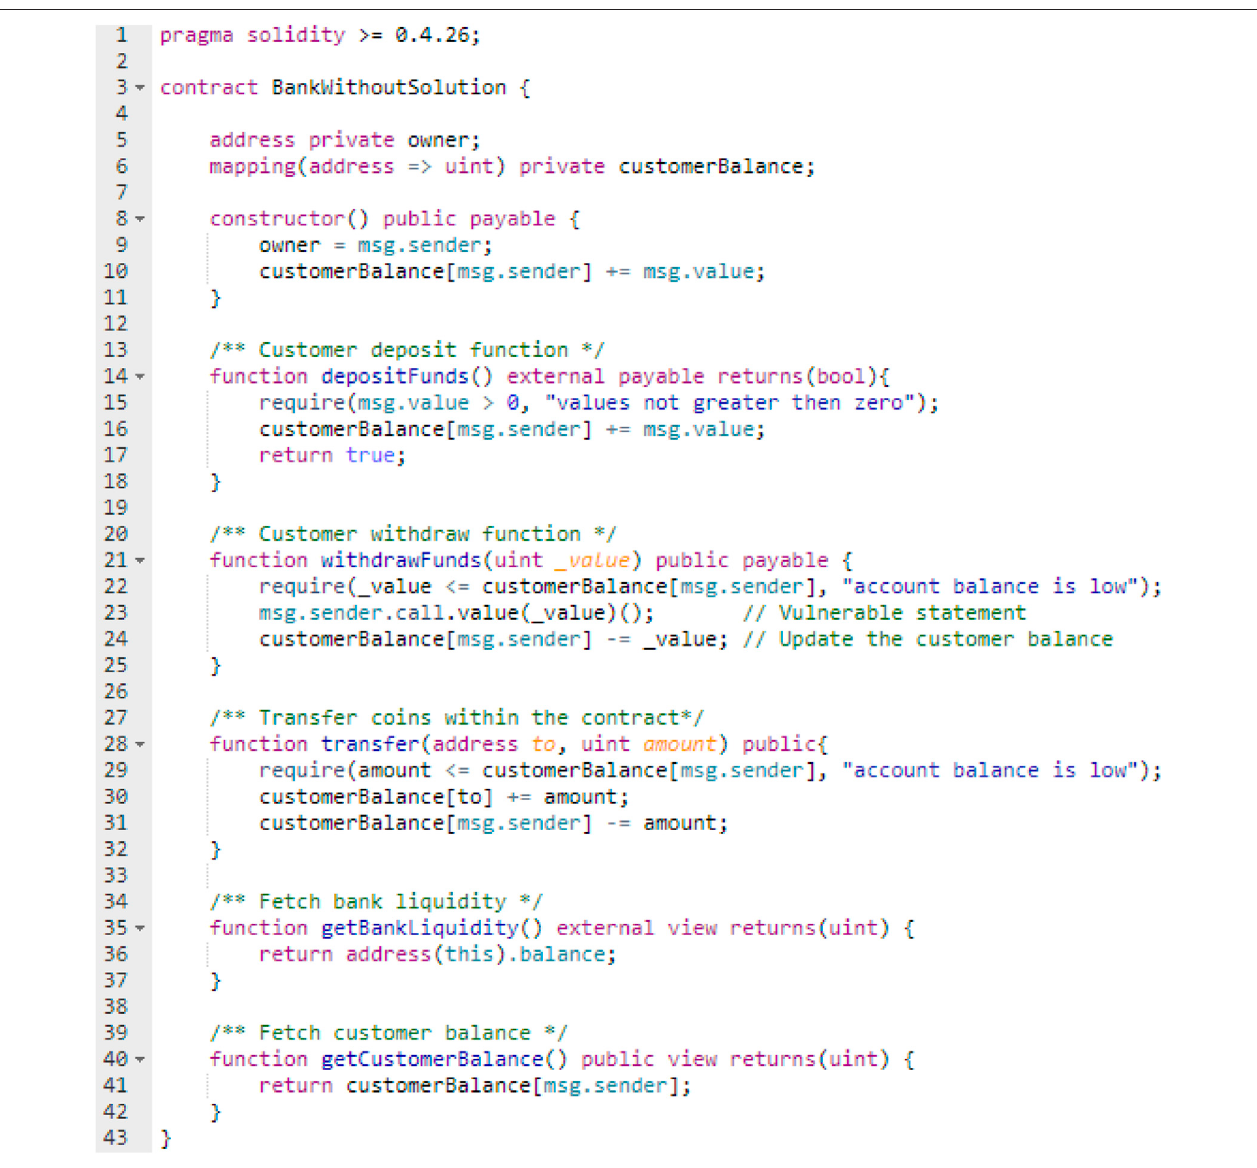
FIGURE 7 | The BankWithoutSolution{} Figure 5 in Section Implementation of the Solution , which contains the vulnerability in line (46). The attack sequence diagram for the second test scenario in the single-function reentrancy attack case study is shown in Figure 9 . All of the transactions and calls involved in the second test scenario are shown in Supplementary Appendix 2 .